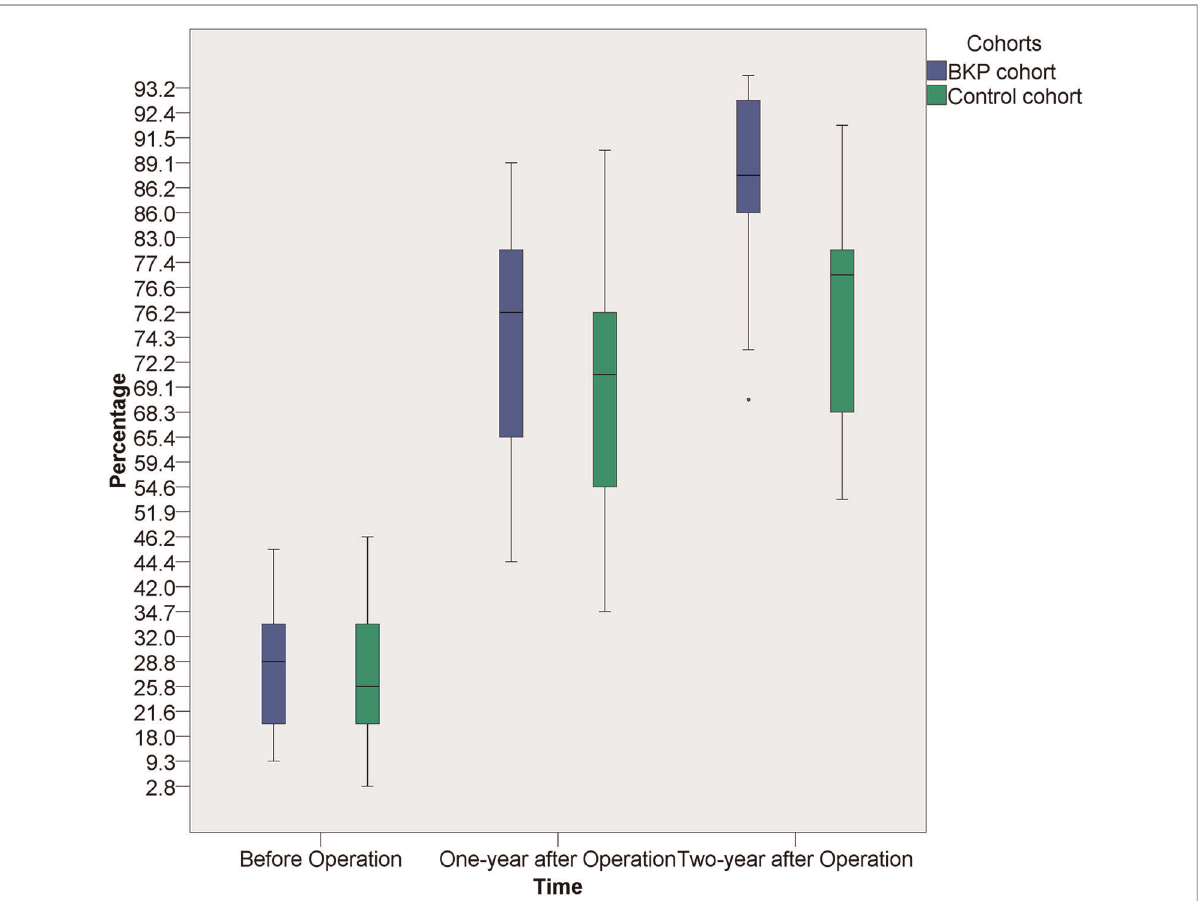
FIGURE 3 The heights of the diseased vertebral at 1-year and 2-year after surgery showed a signi fi cant increment, both intra the BKP cohort and the control cohort. The average recovery speed was higher in the fi rst year. No signi fi cant inter-cohort height difference was observed at 1-year post-operation, but better vertebral height restoration was observed in the BKP cohort at 2-year